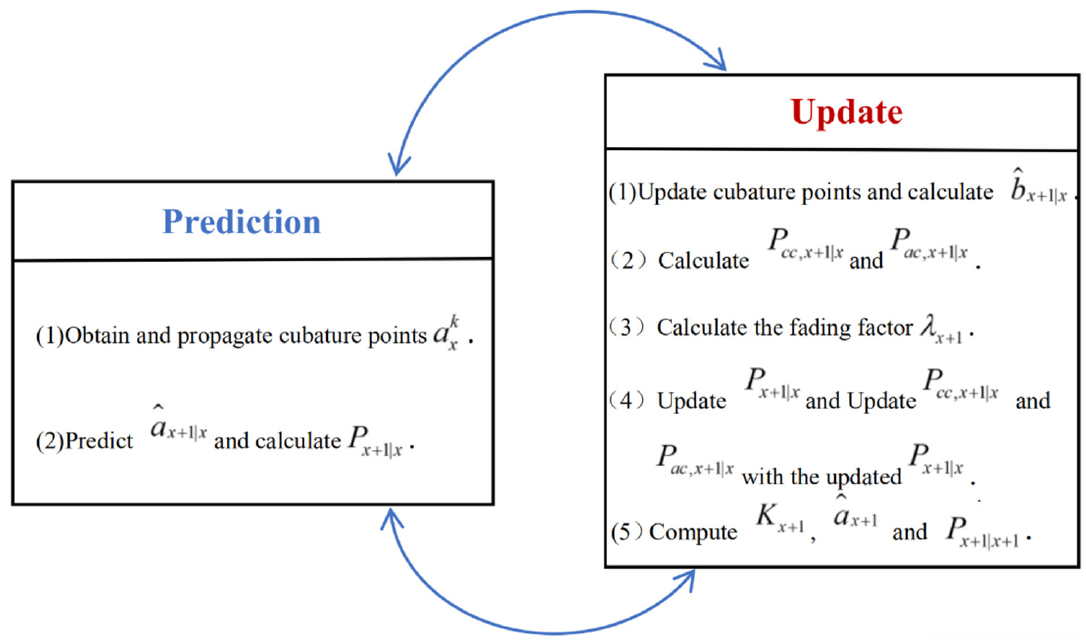
Figure 1. Structure flow chart of AF-H ∞ CKF algorithm.